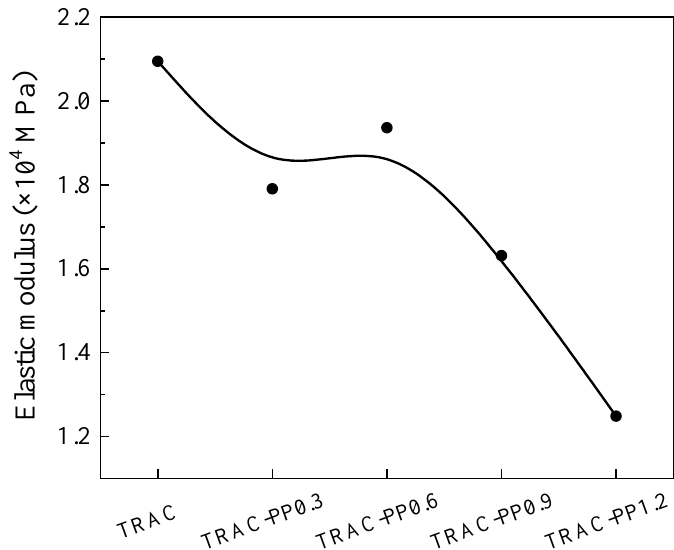
Figure 7. Effect of PPF content on the elastic modulus of TRAC-PP.